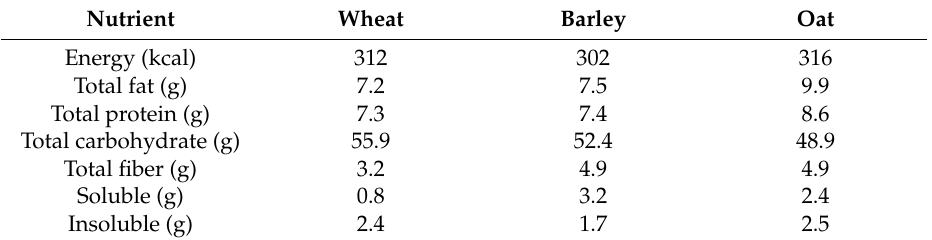
Table 1. Macronutrient composition per two test muffins containing ~48 g whole grain flour. Nutrient Wheat Barley Oat Energy (kcal) 312 302 316 Total fat (g) 7.2 7.5 9.9 Total protein (g) 7.3 7.4 8.6 Total carbohydrate (g) 55.9 52.4 48.9 Total fiber (g) 3.2 4.9 4.9 Soluble (g) 0.8 3.2 2.4 Insoluble (g) 2.4 1.7